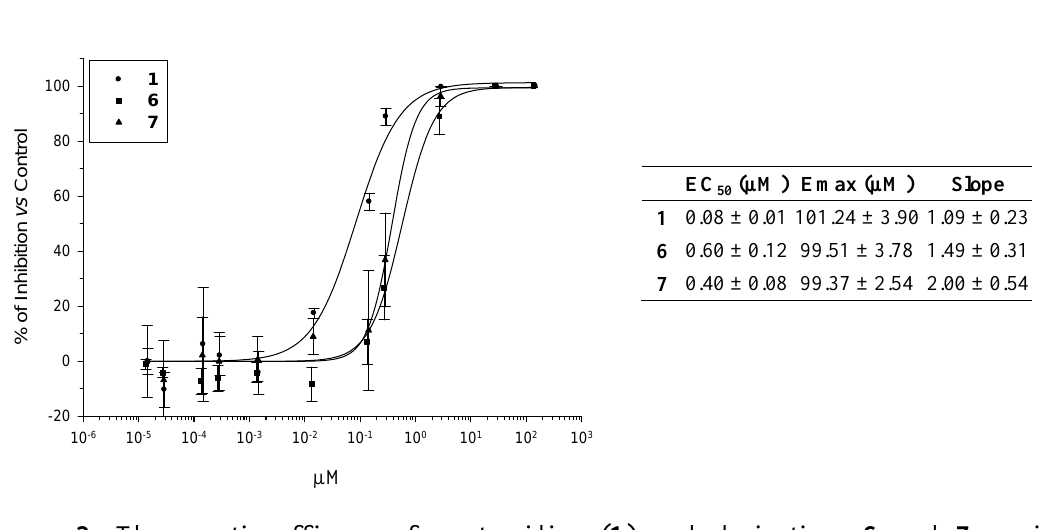
Figure 2. Concentration- in vitro activity relationships of pentamidine ( 1 ) and derivatives 6 and 7 against P. carinii (results were calculated after 4 days of culture).